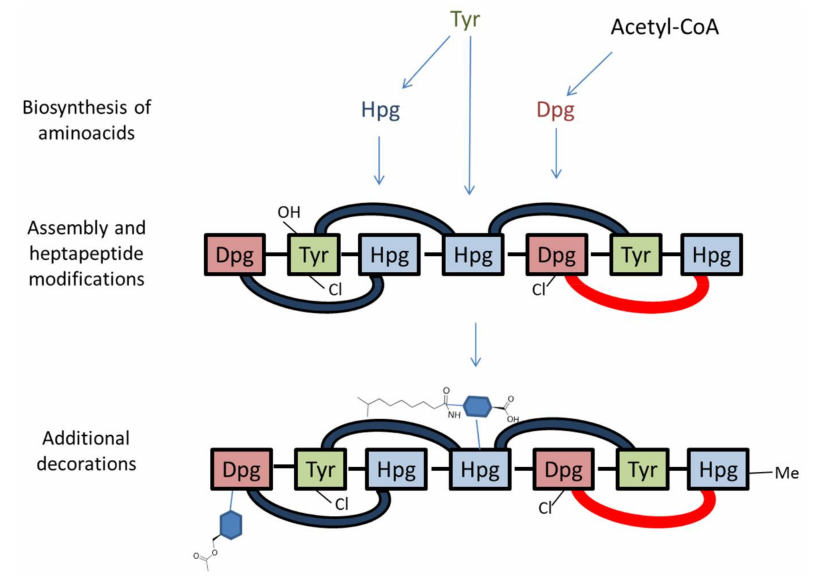
Figure 3. Simplified model of O -acetyl A40926 biosynthesis. Note that the heptapeptide is drawn right (N-terminus) to left (C-terminus), consistent with Figure 1. Cross-links are indicated by blue (C–O–C) or red (C–C) arcs. Sugars are represented as blue hexagons. Refer to Figure 2 and Table 1 for